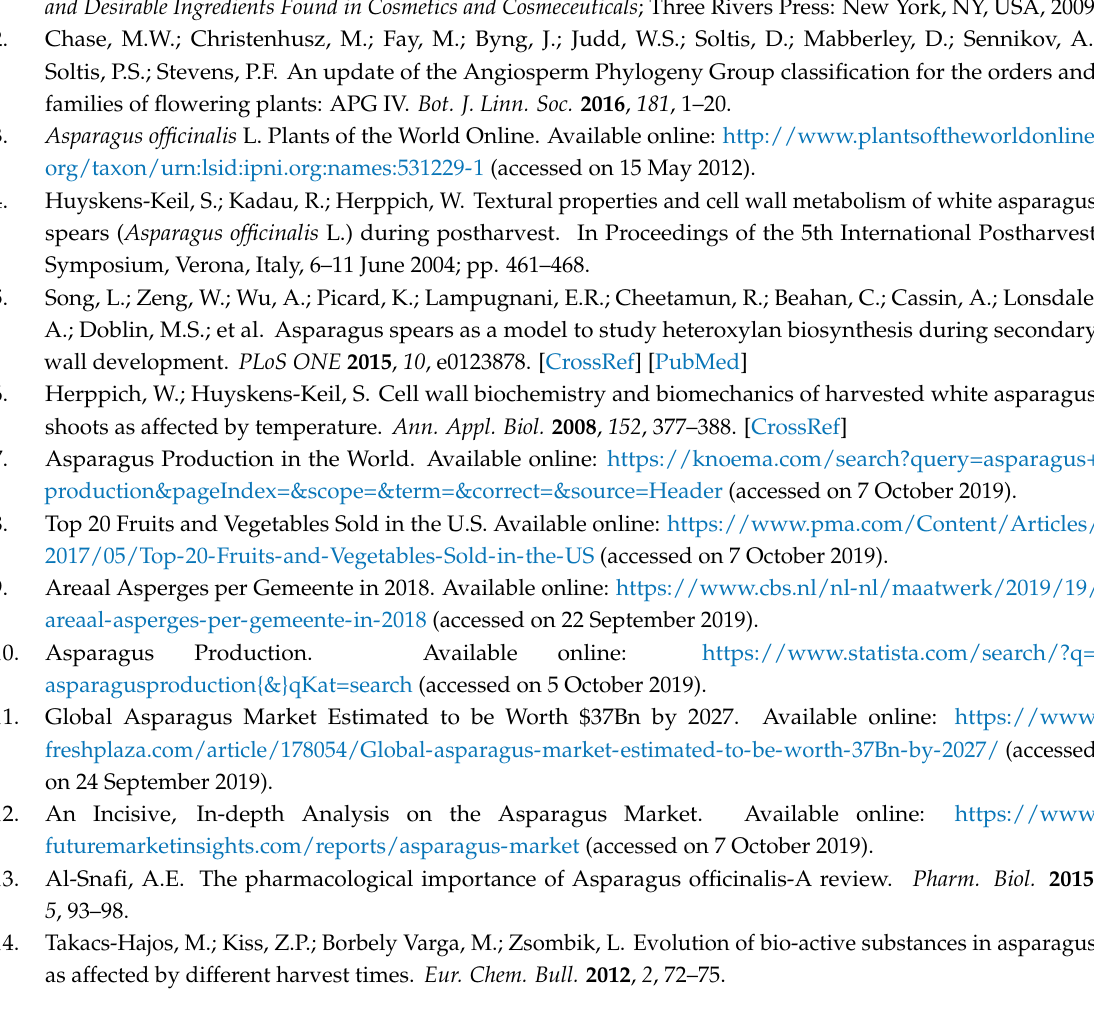
Table S1: List of non-volatile secondary metabolites in A. officinalis , Table S2: List of volatile secondary metabolites in A. officinalis